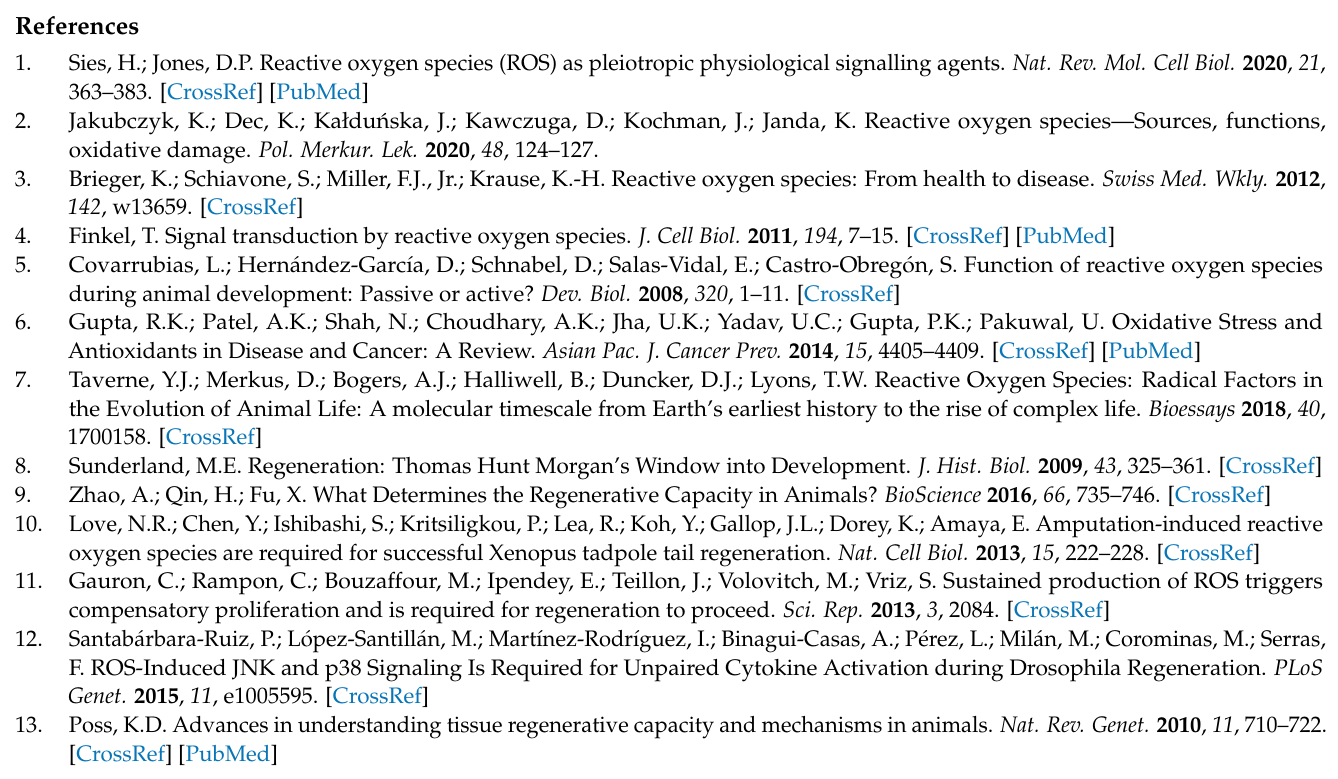
oxygen species (ROS) in general (additional images), Figure S2: In vivo visualisation of superox- ide (additional images), Figure S3: In vivo visualisatoin of hydrogen peroxide (additional images), Figure S4: The fluorescent signal observed is ROS production specific and not related to autofluo- rescence and ROS production is inhibited after treatment with DPI, Figure S5: Localisation of major antioxidant systems in the planarian body (continued), Figure S6: Phenotypes after interfering with the expression of Cu-Zn-sod and Mn-sod , Figure S7: Glutathione content after exposure to inhibitors and phenotypes and stem cell responses after interfering with the expression of gst , Figure S8: Stem cell responses in regenerating worms after exposure to BSO and DMF in different